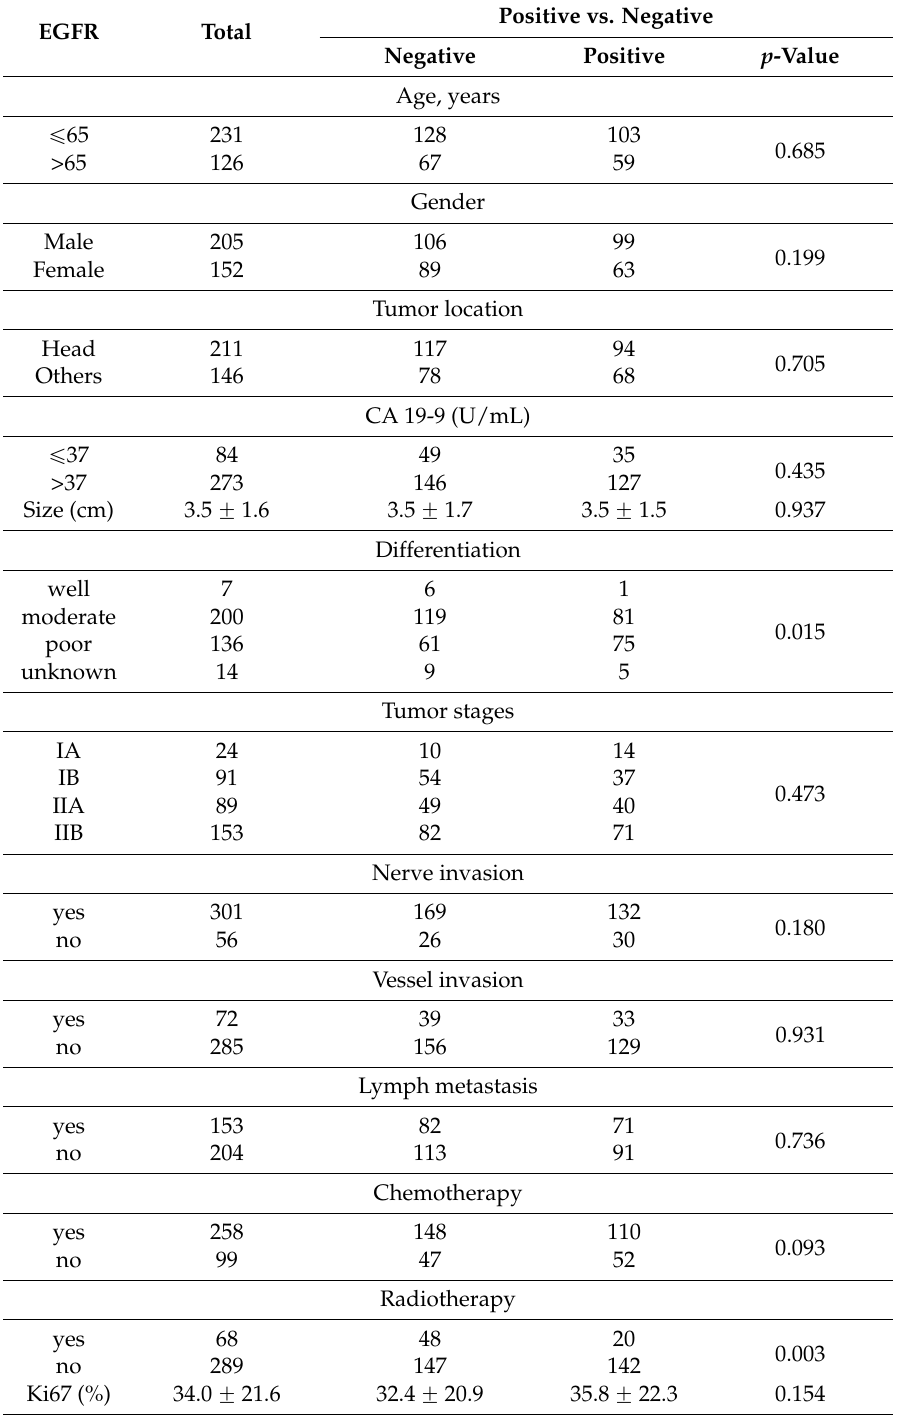
Table 1. Characteristics of patients with pancreatic cancer according to EGFR (epidermal growth factor receptor)